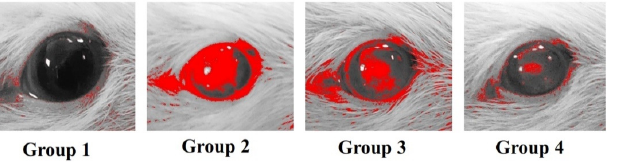
Figure 4. ImageJ-processed photographs of eyes from different groups: group 1 (uninfected untreated rats); group 2 (infected rats without treatment); group 3 (rats treated with GTX aqueous dispersion); and group 4 (rats treated with GTX-loaded cubosomal dispersion). The red color in the processed pictures designates the areas of focal lesions.